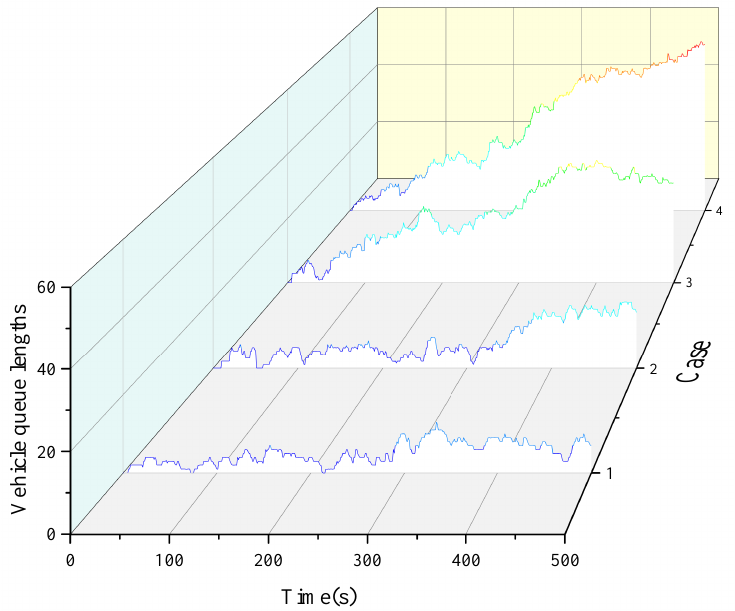
Figure 13. The changing arrival rates for different combinations of λ 1 and λ 2 .